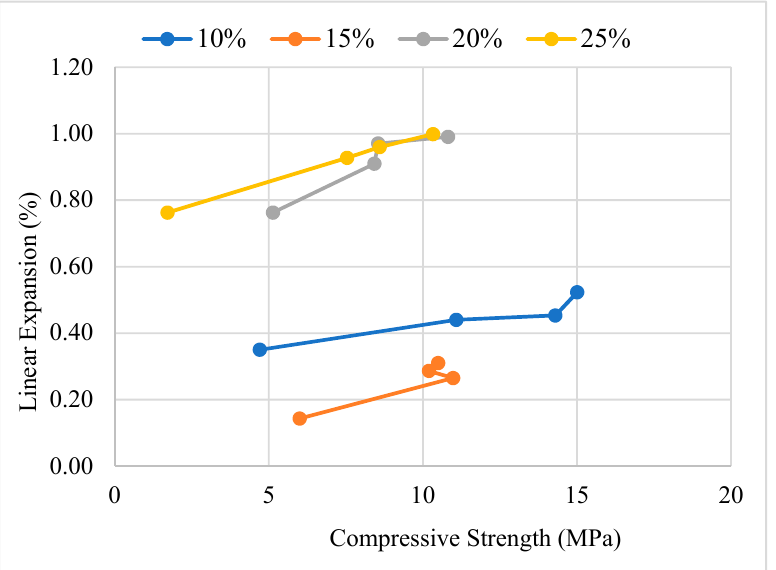
Figure 7. Relationship between compressive strength and linear expansion of samples containing different contents of R additive.